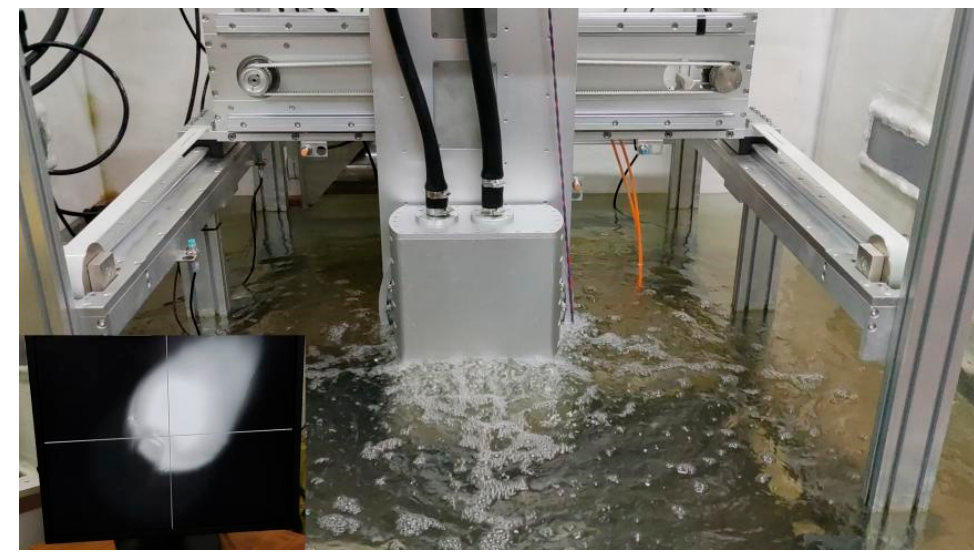
Figure 2. Underwater laser cladding system for underwater laser cladding/remelting processing.